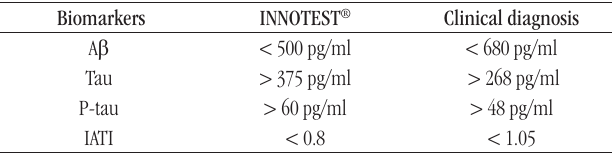
taBLE 4 − Comparative description of cut-off values for diagnosis of AD according to the kit used and the clinical diagnosis